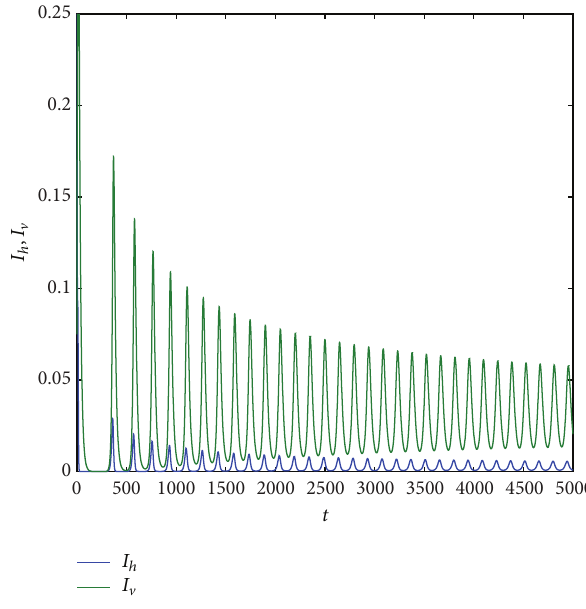
Figure 8: Trajectory picture with time 𝑡 when 𝑟 = 0.8 , 𝐾 = 10 , = 1 , 𝑎 = 1 , 𝑎 = 0.3 , 𝑑 = 0.7486 , 𝛾 𝛽 1 1 2 ℎ = 0.06 , 𝛽 = 0.26 , and 𝑁 = 2 . 𝑑 V 2 V